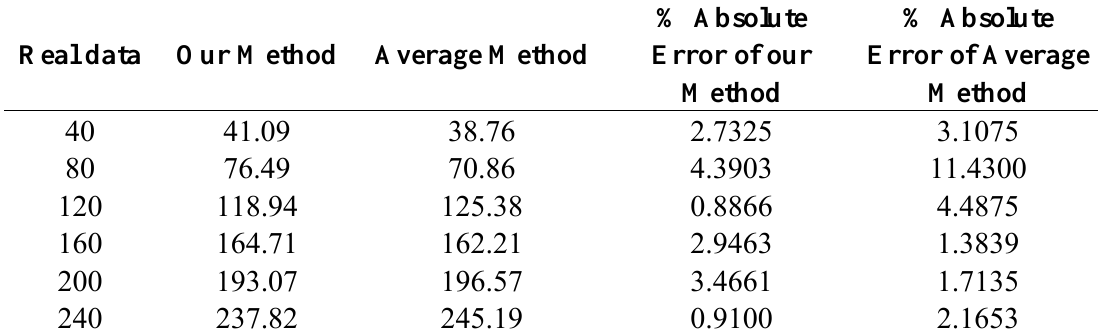
Table 5. Experimental results of